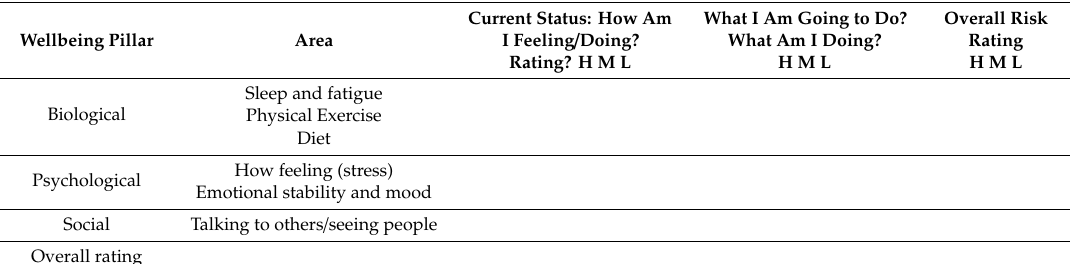
Table 9. Self-assessment checklist.